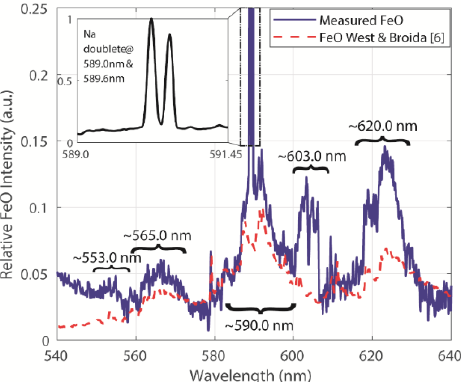
Figure 7. Spectral FeO emission measurements and reference spectral features taken from [26].